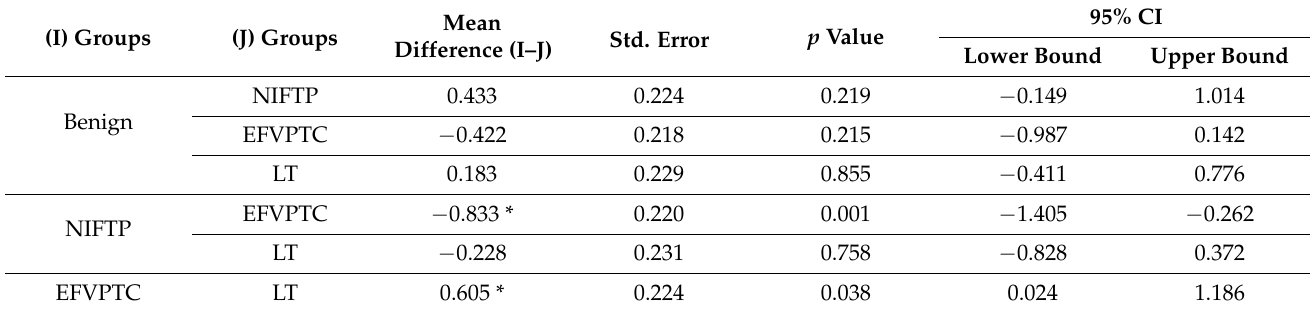
(Table S1), cytoplasmic Gal-3 expression in EFVPTC versus in NIFTP showed a